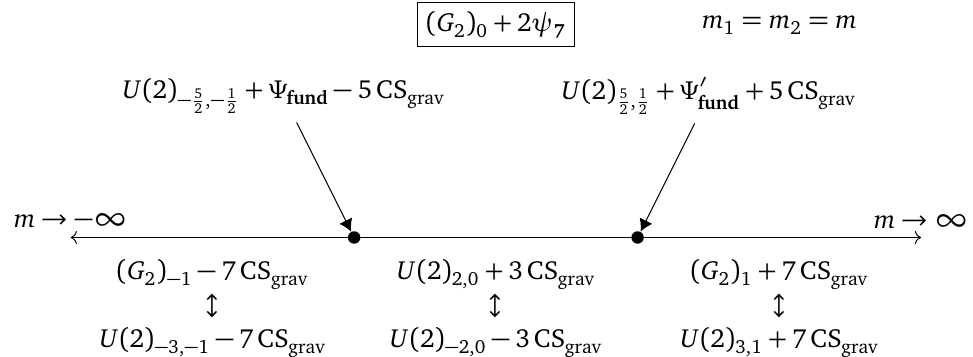
) gauge theory with 2 fermions in the 2 0 = m . In the center is a quantum phase where 1 2